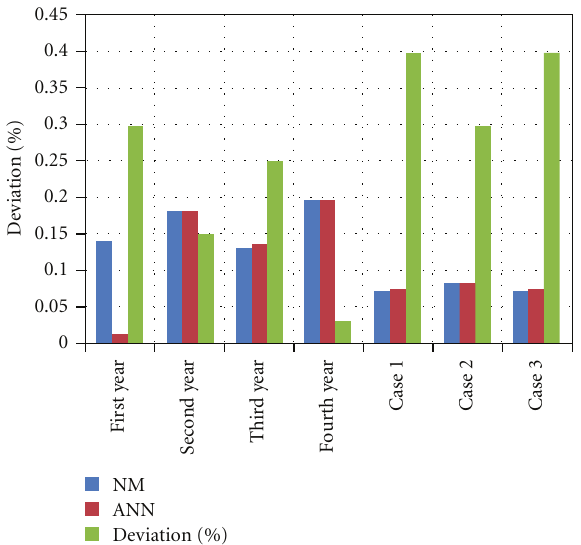
Figure 6: SAIDI values for feeder X12 with deviation less than 0.4.